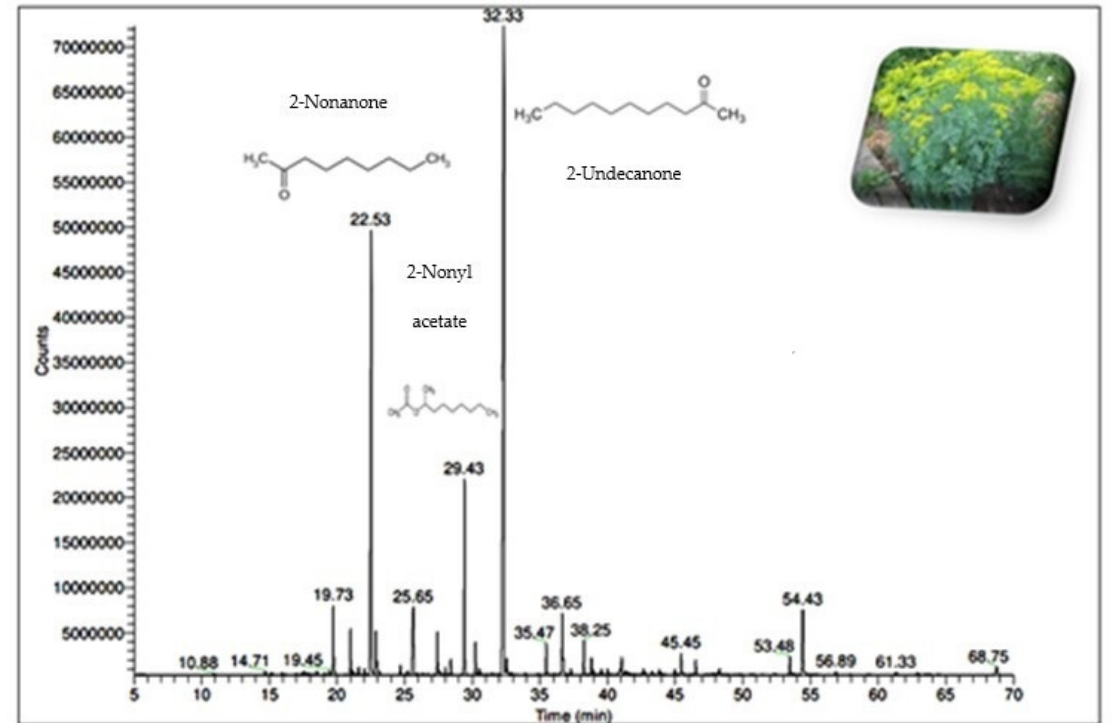
Figure 1. GC-MS chromatogram for Ruta chalepensis essential oil compositions. Main components were detected at Rts 22.53, 29.43, and 32.33 and were assigned for 2-Nonanone, 2-Nonyl acetate, and 2-Undecanone, respectively.